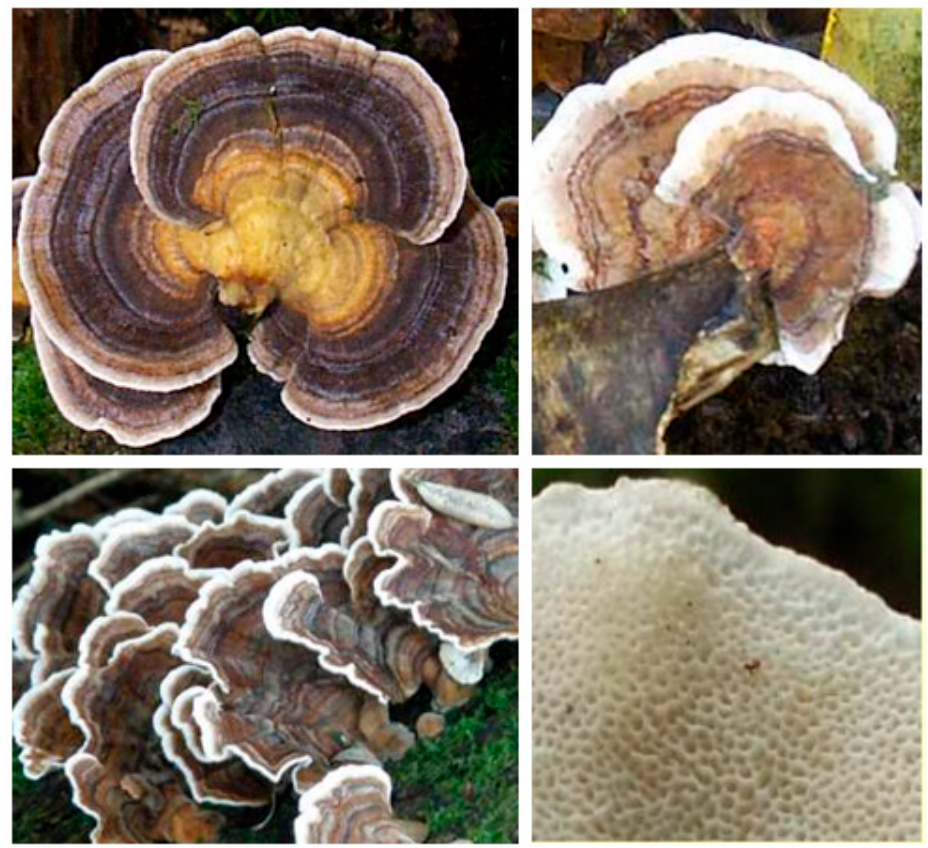
Figure 1. Morphological features of Coriolus versicolor . The various morphological features of the fungus grown in the UK are shown. While the upper surface shows concentric zones of colours (red, yellow, green, blue, brown, black, and white), the picture in the lower-right shows the polyporous nature of the underside portion of the fungus. Pictures are a kind gift of first-nature.com (https://www.first-nature.com/fungi/trametes-versicolor.php#distribution).